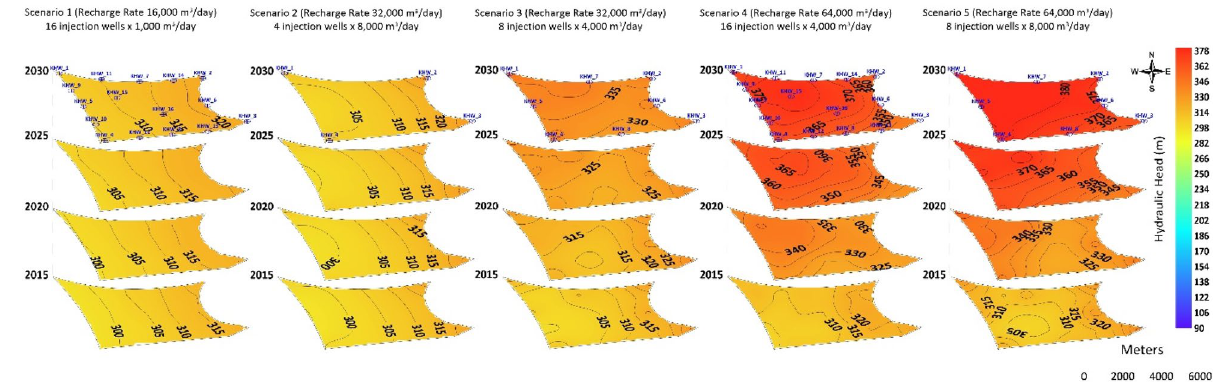
Figure 6. Simulated hydraulic heads at Al-Khrair site for the five recharge